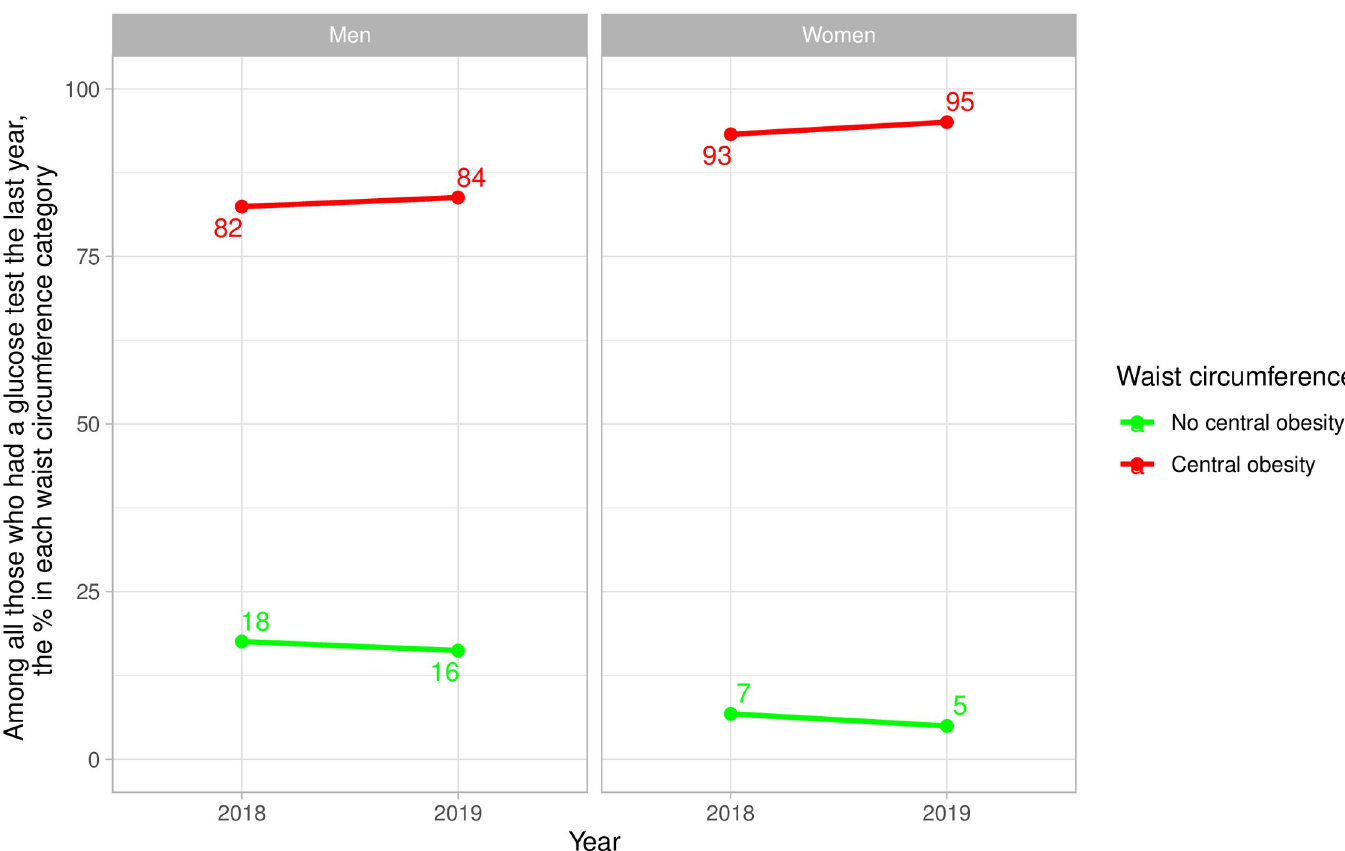
Fig 2. National time trends of glucose test by waist circumference categories stratified by sex.